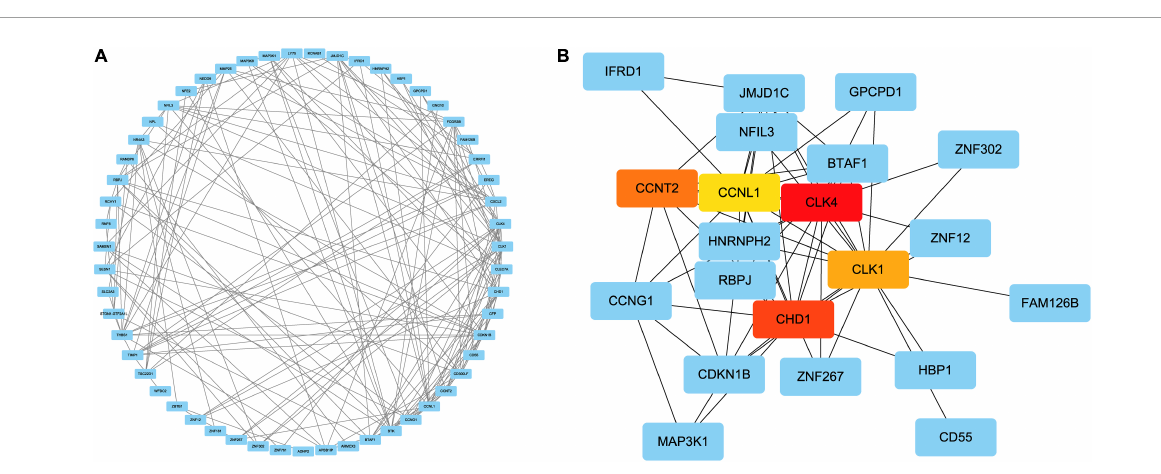
FIGURE4 (A) PPI network of common DEGs among SARS-CoV-2 and asthma. In the figure, the circle nodes represent DEGs and edges represent the interactions between nodes. The PPI network has 64 nodes and 166 edges. (B) Determination of hub genes from the PPI network by using